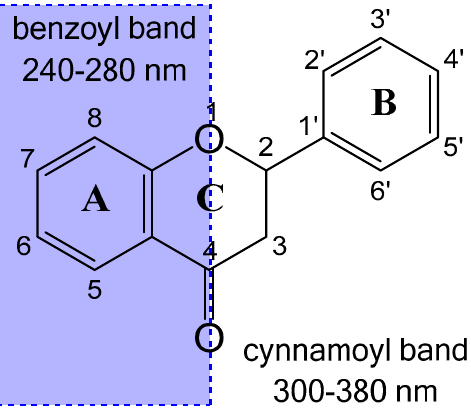
Figure 1. Benzoyl unit responsible for the band II and cinnamoyl unit responsible for the band I in absorption spectra of flavanones